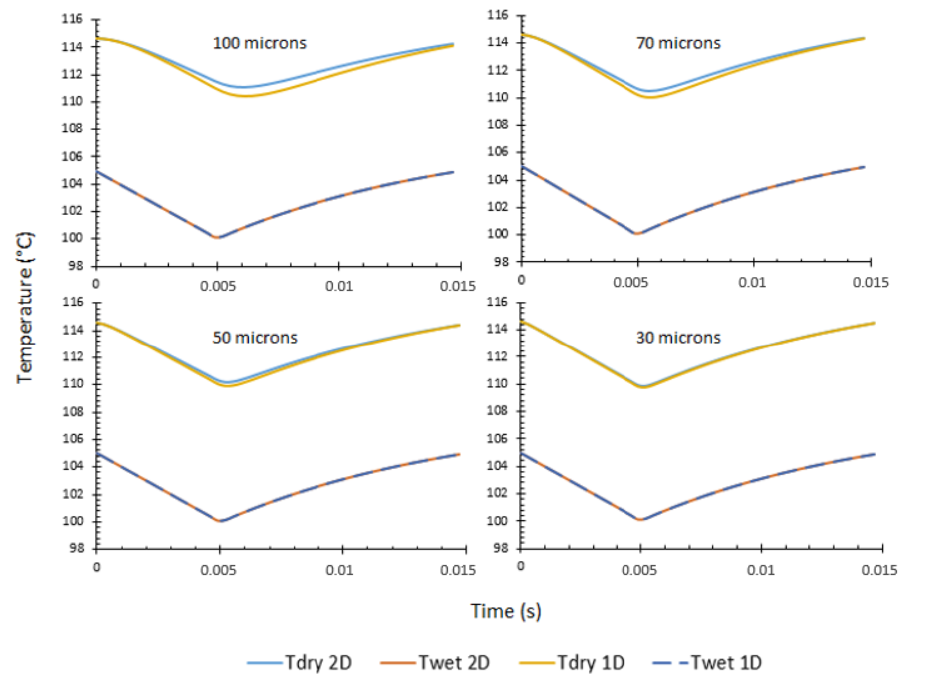
Figure 18. Illustration of the 2D diffusion effect over the dry temperature for various thicknesses. This problem–solution was solved with the following values: N x = 50, N y = 200, n = 50, t g = 0.005s, t w = 0.01s, , ∆ t = 0.00031s, P = 1 bar , I = 400A, ∆ T = 5 ◦ C, C P = 502 J/K · kg, λ = 15 W/m ·